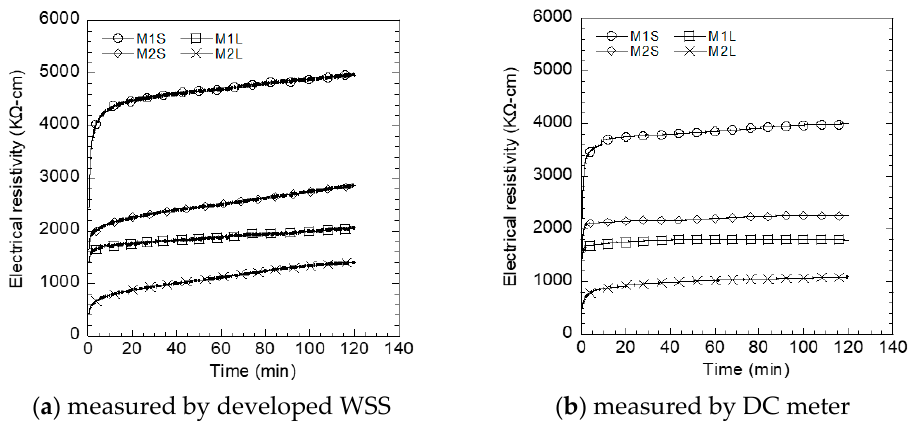
Figure 12. Polarization of S-UHPCs.